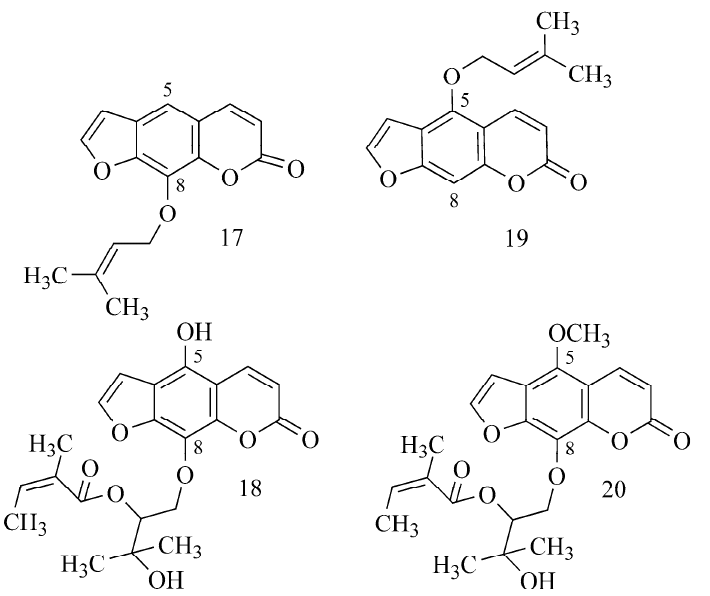
Figure 7. Chemical structures of imperatorin ( 17 ), heraclenol-2 ′ -O-angelate ( 18 ), isoimperatorin ( 19 ) and byakangelicin-2 ′ -O-angelate ( 20 ).